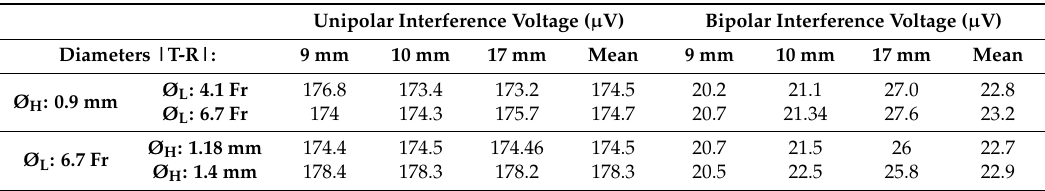
Table 5. Comparison between 24 different configurations; sensing mode: unipolar/bipolar, tip-to-ring distance: 9 mm/10 mm/17 mm, thin Ø H : minimum and maximum bipolar Ø L , maximum Ø L : 3 different Ø H ) (per 1 kV · m − 1 50